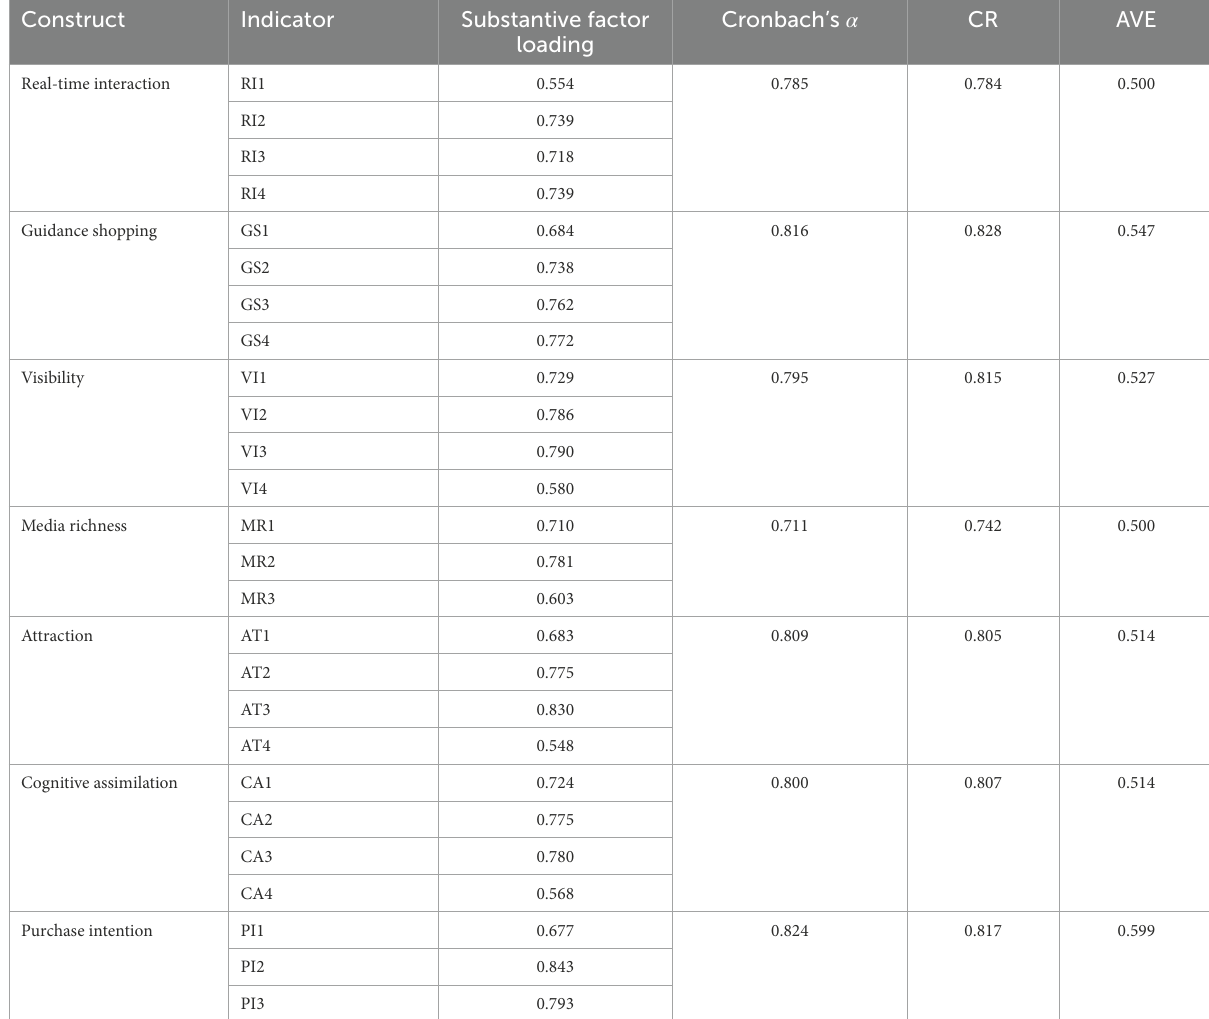
TABLE 3 Reliability and validity analysis of construct.